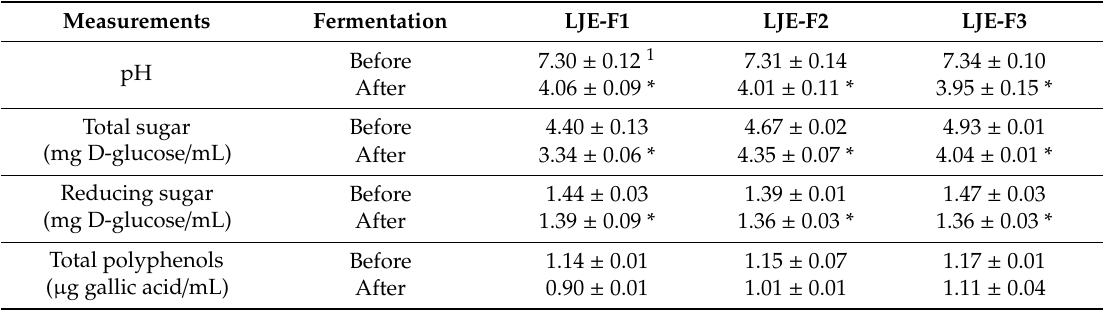
Table 1. Changes of pH, total sugar contents, reducing sugar content, and total polyphenol contents in LJE-Fs by